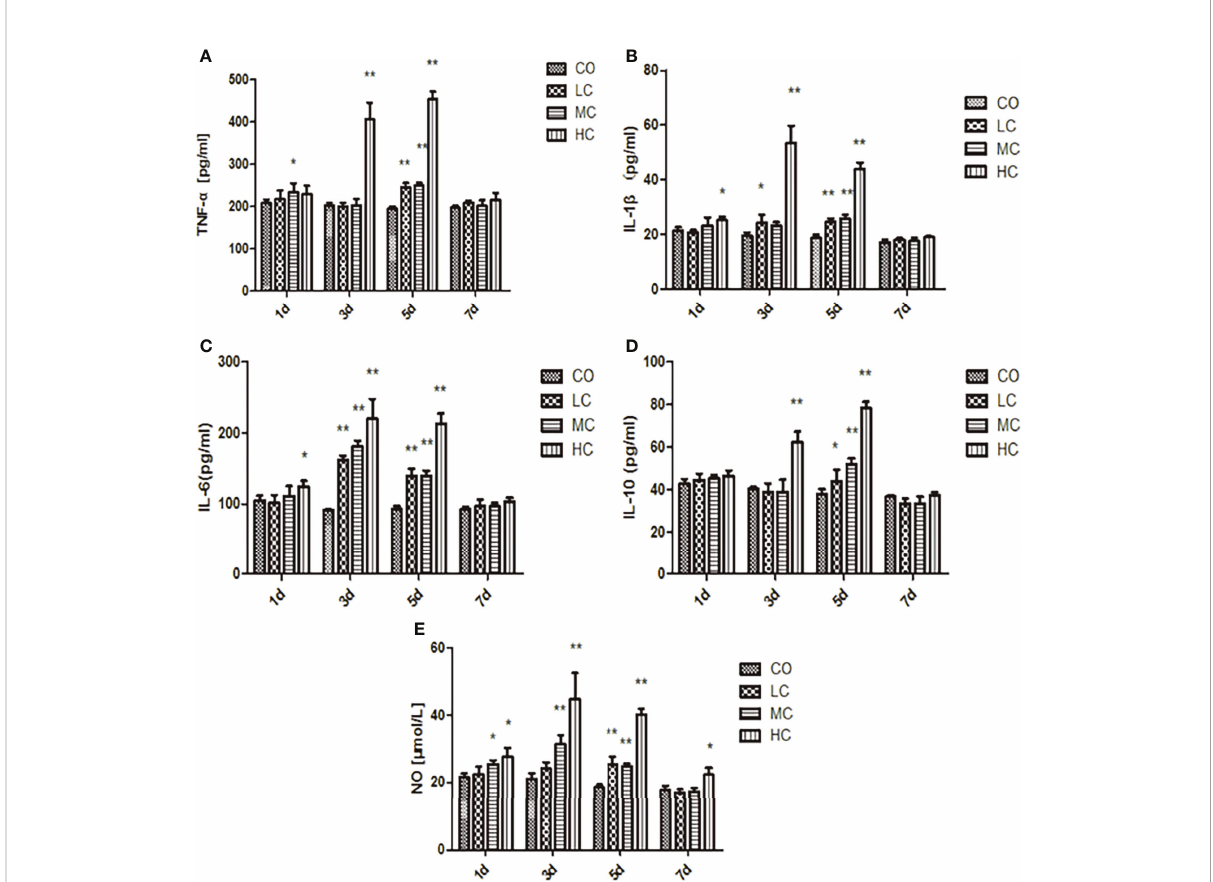
FIGURE 3 The release of in fl ammatory factors ( A , TNF- a ; B , IL-1 b ; C , IL-6; D , IL-10; and E , NO) in the serum of SD rats after intraperitoneal injection of C. malonation LPS for 1, 3, 5, and 7 days. * p < 0.05 compared to control (CO); ** p < 0.001 compared to CO. LC, low concentration; MC, moderate concentration; HC, high concentration; TNF- a , tumor necrosis factor- a ; IL-1 b , interleukin-1 b ; IL-10, interleukin-10; IL-6, interleukin-6; NO, nitric